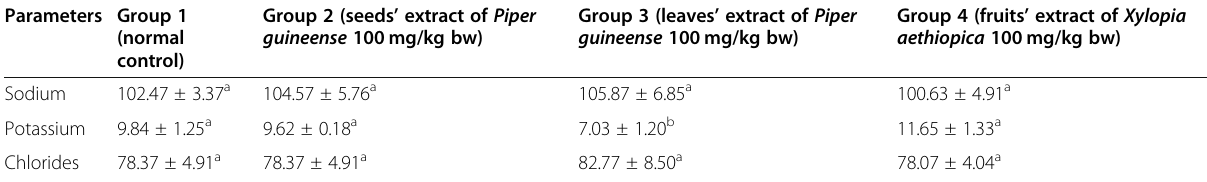
Table 4 Concentrations of serum electrolytes (mmol/L) in rats administered ethanolic extracts of fruits of Xylopia aethiopica and seeds and leaves of Piper guineense